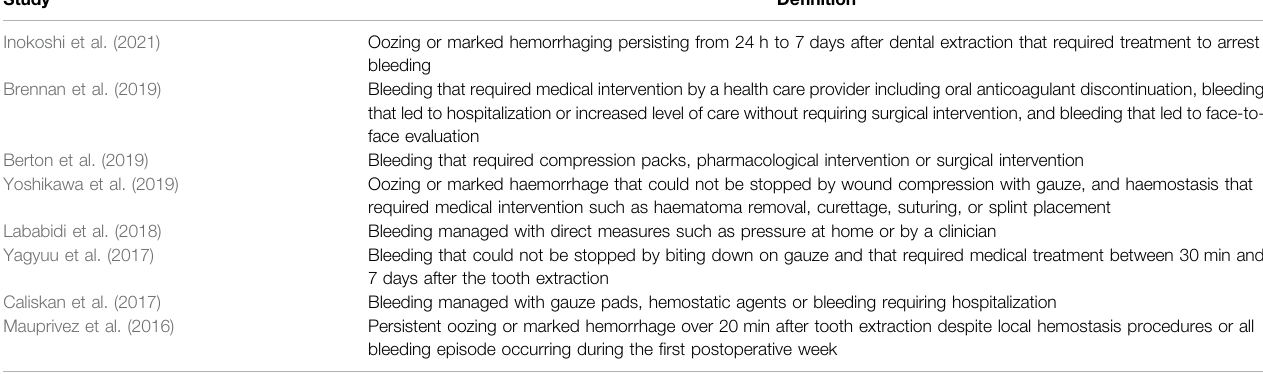
TABLE 2 | De fi nition of bleeding outcome in included studies. Study